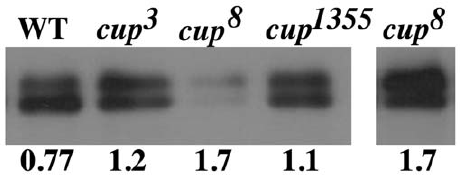
Figure 8. The ratio of the upper and lower Orb isoforms is altered in cup ovaries. In wild type, the lower isoform is typically most abundant, while in cup mutant ovaries the level of the upper isoform is increased. The ratio of upper to lower phosphoisoforms in the WT is 0.75. In other experiments (n=6) the range for WT was 0.74– 0.84 with an average value of 0.77. In the experiment shown here, the ratio for the cup mutants is increased to 1.3, 1.9 and 1.1 for cup 3 , cup 8 and cup 1355 , respectively. Two different exposures of the cup 8 lane are shown. The average of three experiments for cup 3 was 1.2, cup 8 was 1.7 and cup 1355 was 1.1. The average ratio is shown in the